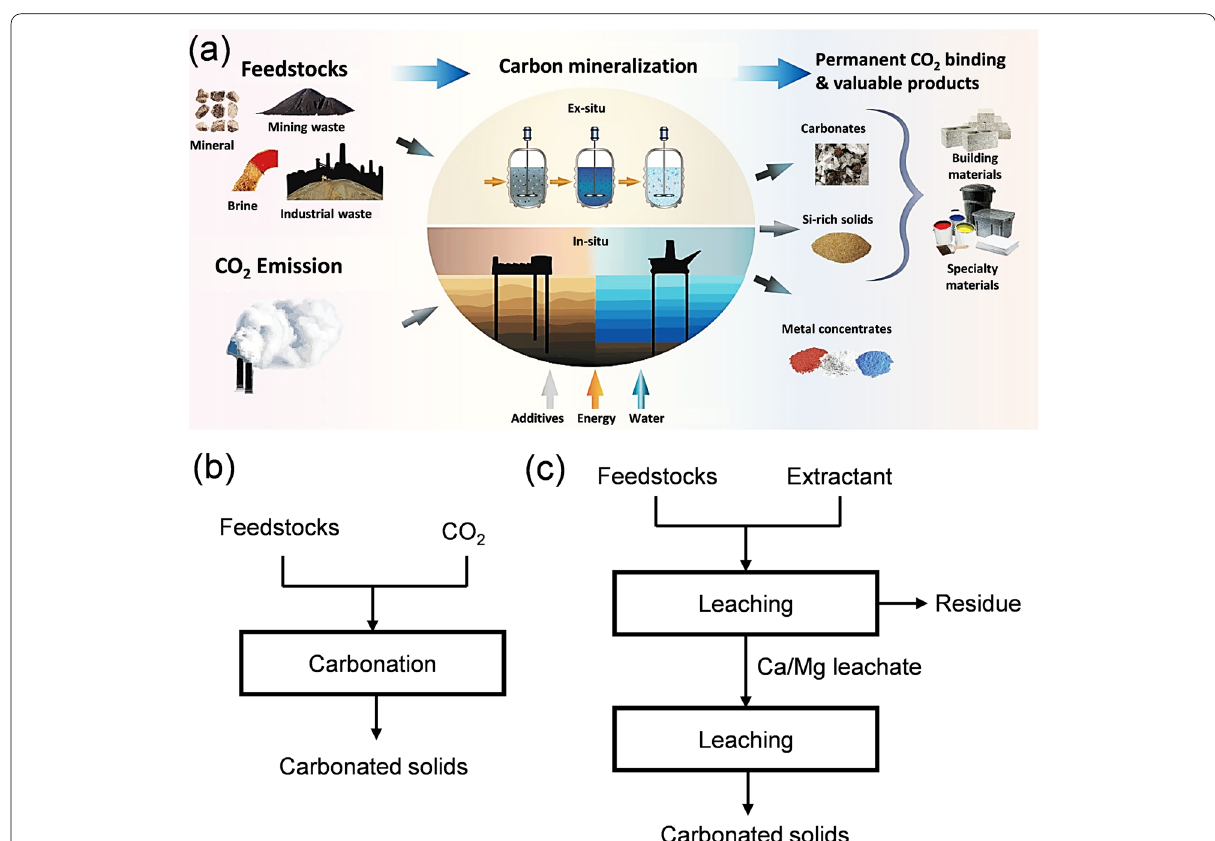
Fig. 6 a Carbon mineralization from various feedstocks to different products. Image courtesy of Florent Bourgeois, Laboratoire de Génie Chimique; Au‑Hung Park and Xiaozhou Sean Zhou, Columbia University. Process flow charts of b direct and c indirect